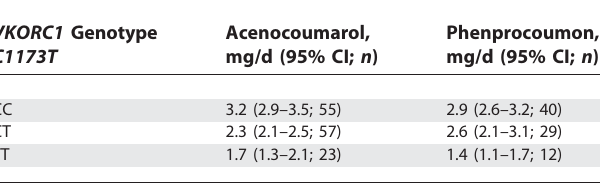
Table 1. Relationship between C1173T Genotype and VKA Mean Daily Dose Requirement in Control